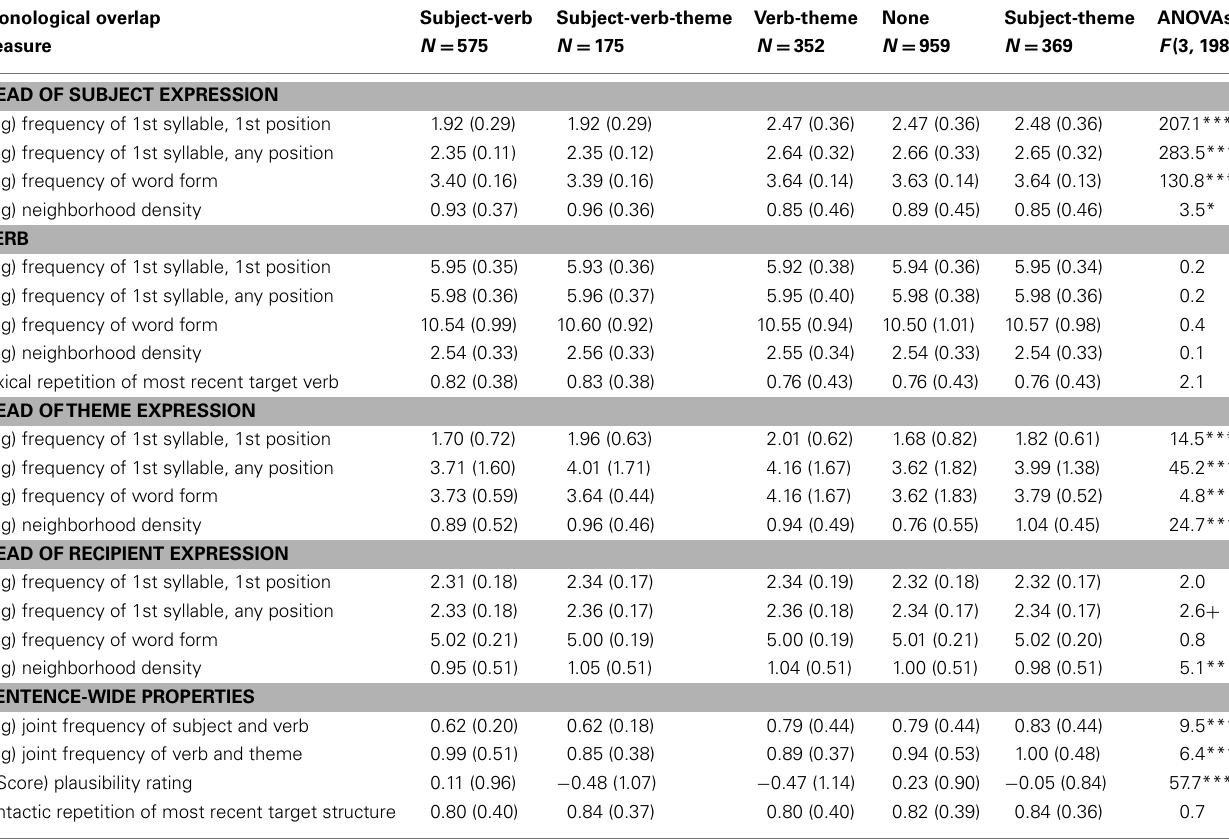
TableA3 | Means and SD of control predictors in the five conditions summarized inTable